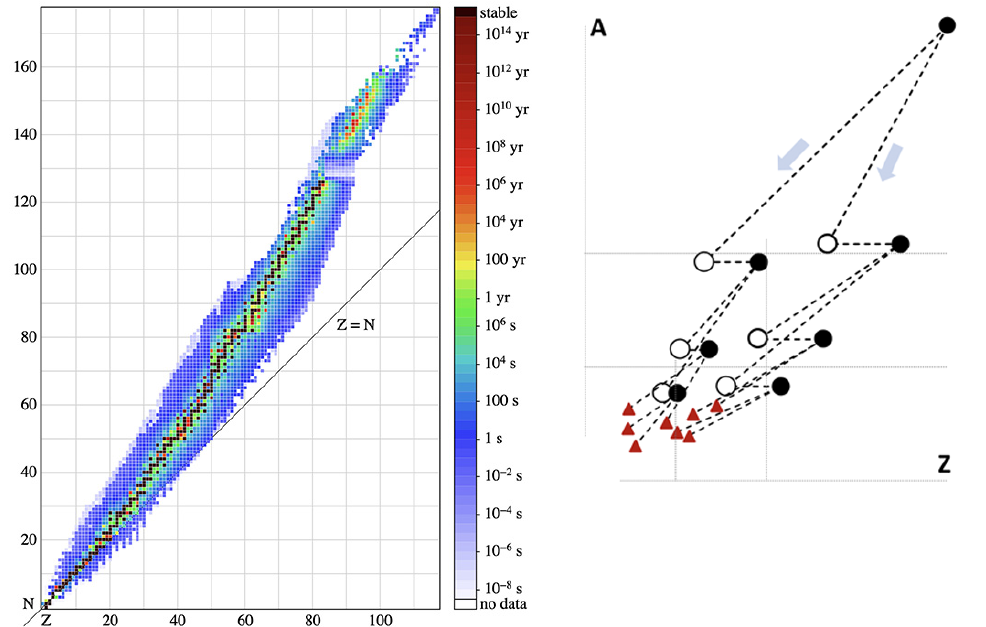
Figure 1. Left Panel : Half-lives of isotopes (Z is a number of protons and N is a number of neutrons in a nucleus). Data from National Nuclear Data Center (NuDat2 database 6/1/2012) [25]. Right Panel : Dispersion in nucleogenetic cascades in ZA-plane (where A = Z + N). For visual simplicity, only fission and β -decays are